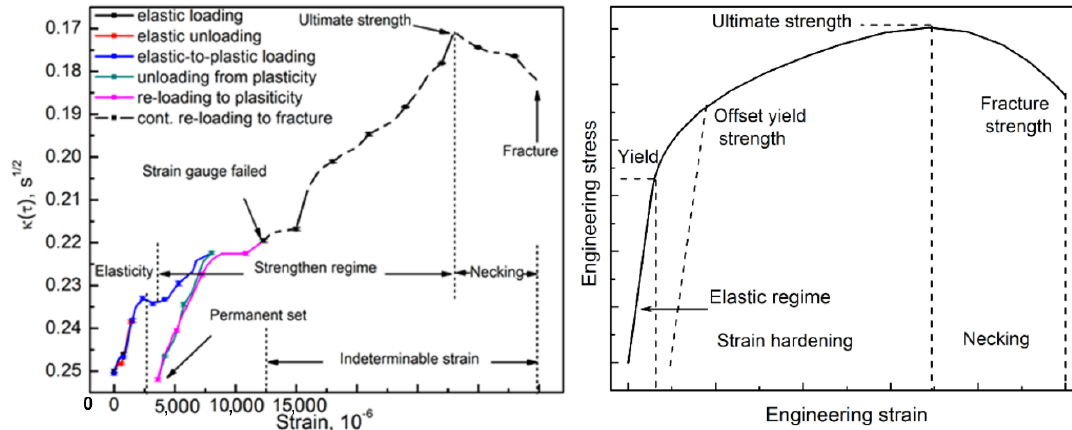
Figure 9. Composite thermal parameter κ as a function of strain that shows good analogy with a typical engineering stress-strain curve, reproduced from [100] with permission from Elsevier © 2016.